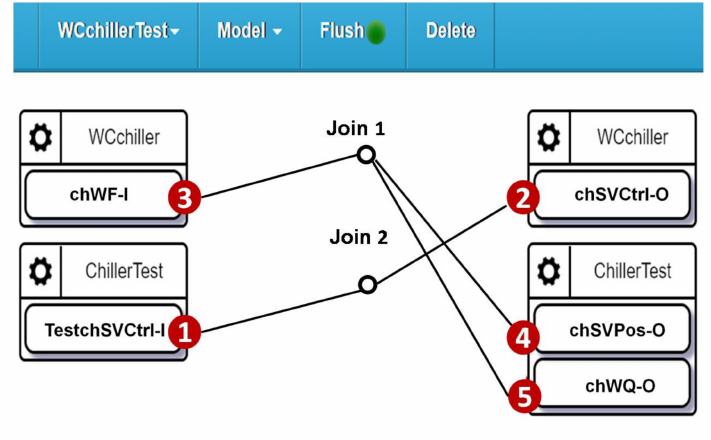
Figure 15. Self-test configuration for the water-cooled chiller in the smart building.